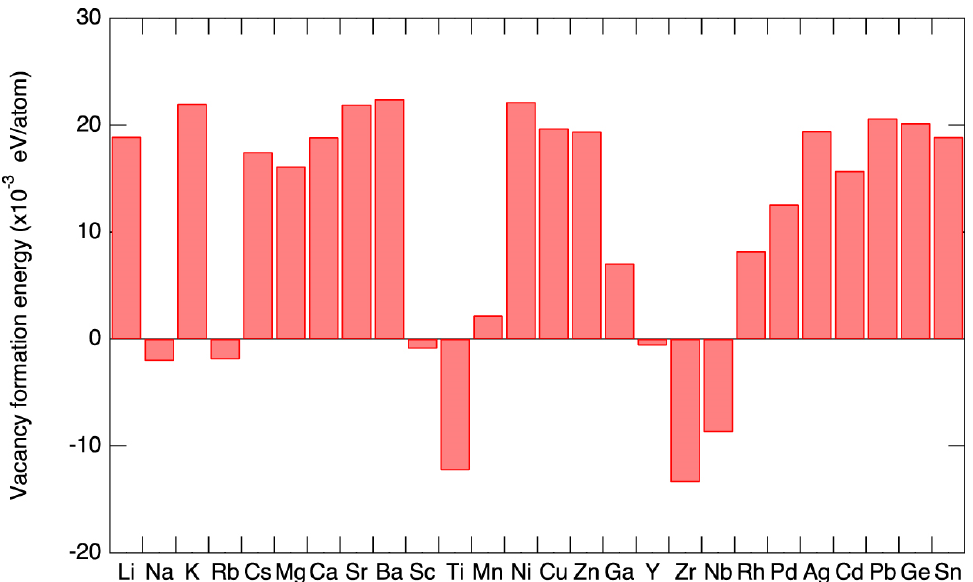
Figure 33. Calculated vacancy formation energy in MASnI 3 when one Sn atom of the crystal lattice is replaced. Reproduced with permission [157]. Copyright 2022, The Japan Society of Applied Physics.